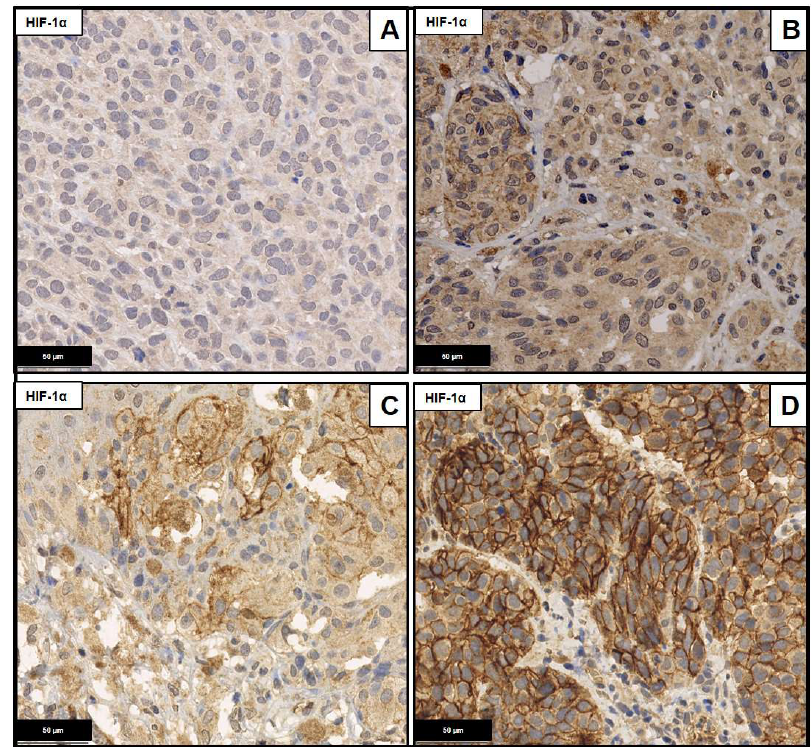
Figure 5. HIF-1α staining, magnification 40×. ( A ) Absence of staining (GIS-score 0). ( B ) Weak positivity in <10% (GIS-score 1). ( C ) Moderate positivity in 10–50% of tumor cells (GIS-Score 4). ( D ) Strong positivity in 50–90% of tumor cells (GIS-Score 8).